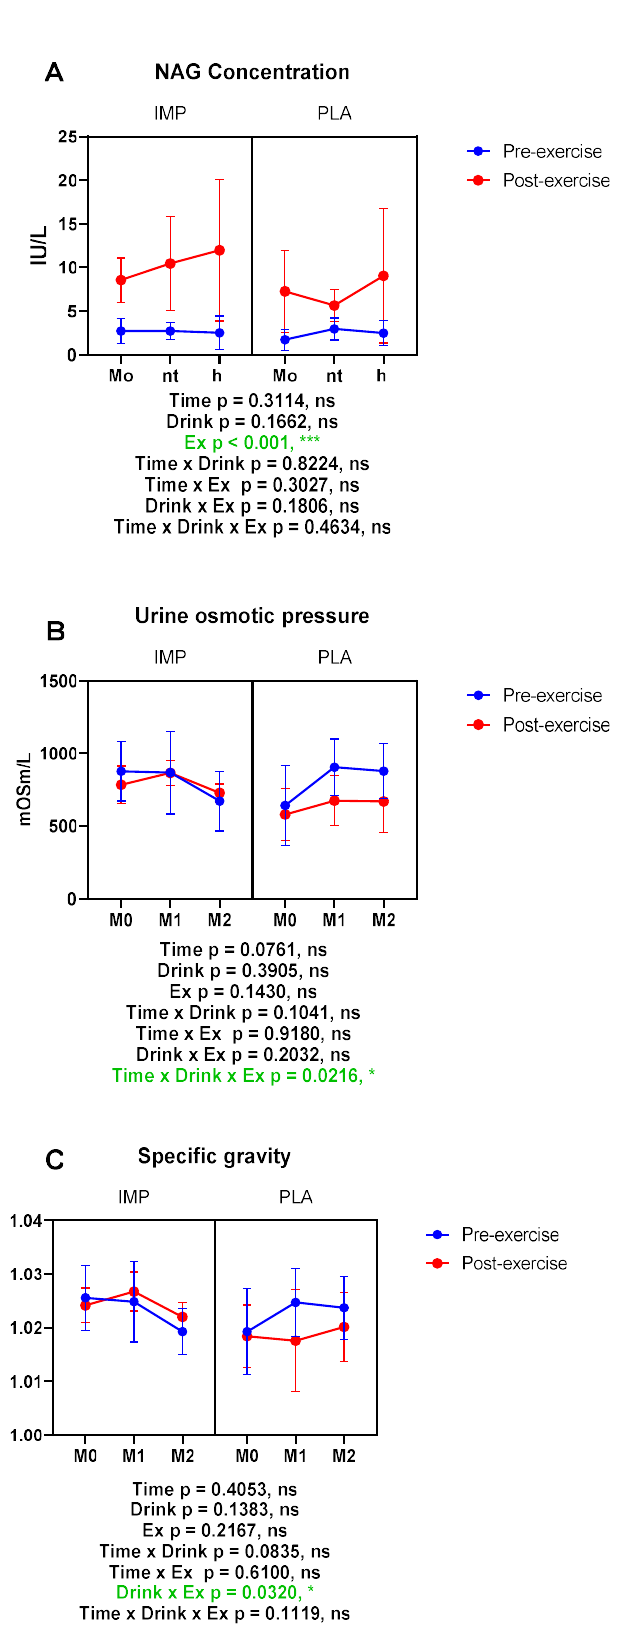
Figure 4. Results of renal function. ( A ) N -acetyl- β - d -glucosaminidase (NAG) concentration, ( B ) urine osmotic pressure, and ( C ) urine-specific gravity. The data are presented as means ± SD. * p < 0.05, and *** p < 0.001. Green text indicates a significance <0.05